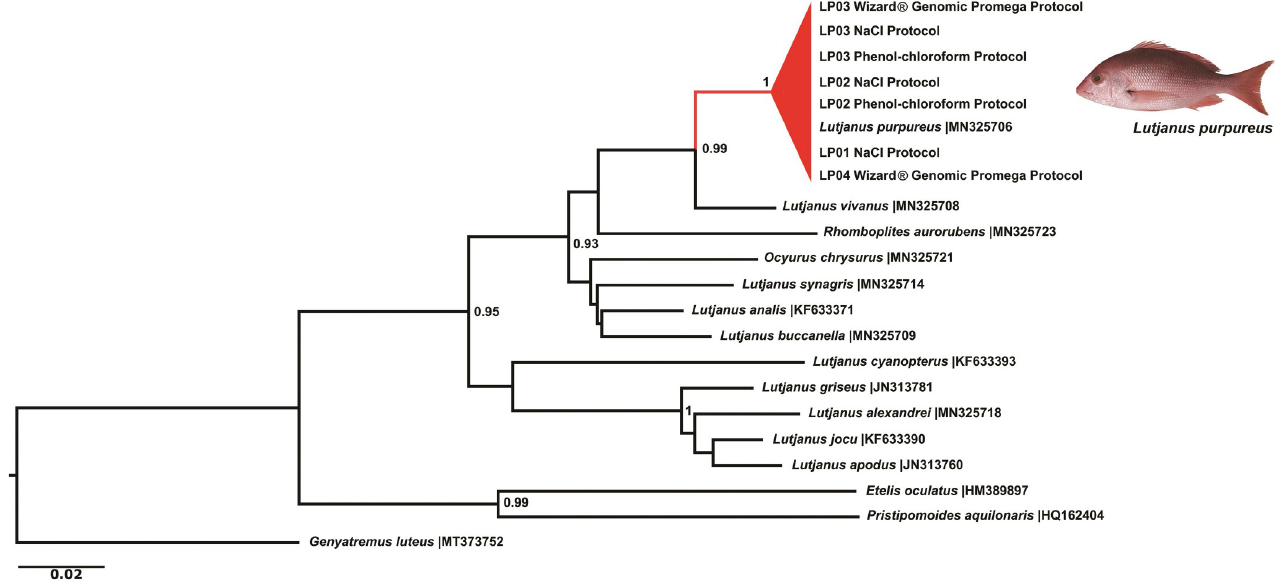
Fig 5. The Neighbor-Joining tree obtained from the pilot essay with COI sequences of L . purpureus obtained from three DNA methods and other Lutjanidae species from the Brazilian coast. LP: Lutjanus purpureus . The species Genyatremus luteus (Haemulidae) was used as an outgroup.